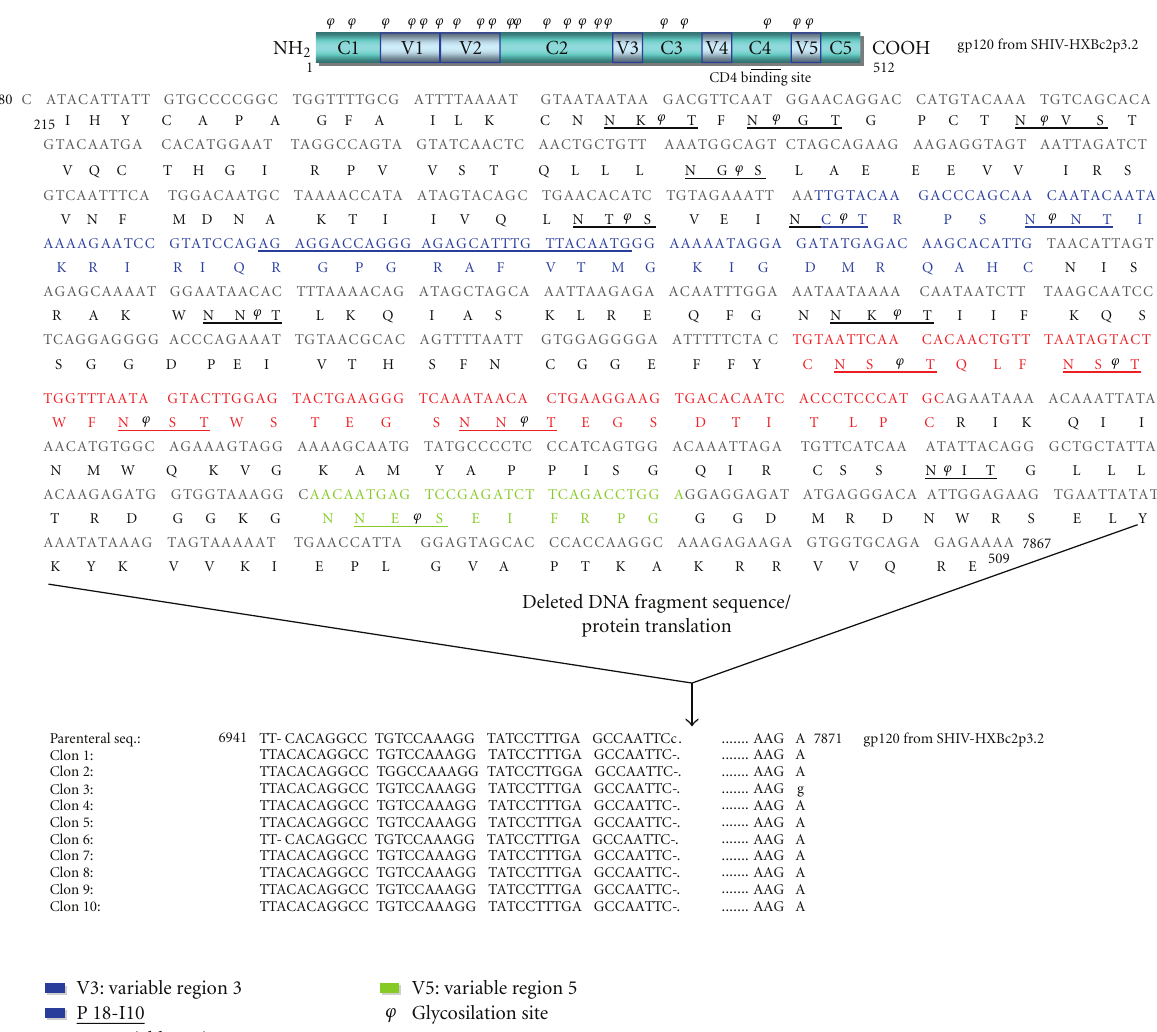
Figure 3: Multiple HIV-1gp120 DNA sequence alignment carrying the ∼ 900-bp deletion from the mutant rBCG:HIV-1gp120 (pMV261) colonies. HIV-1gp120 DNA sequences of 10 mutant rBCG:HIV-1gp120 (pMV261) colonies were aligned and compared with the parental nucleotide sequence of the HIV-1gp120 gene. The ∼ 900 bp deleted fragment (sequence and position shown in the scheme) structurally corresponds to the gp120 core (see protein